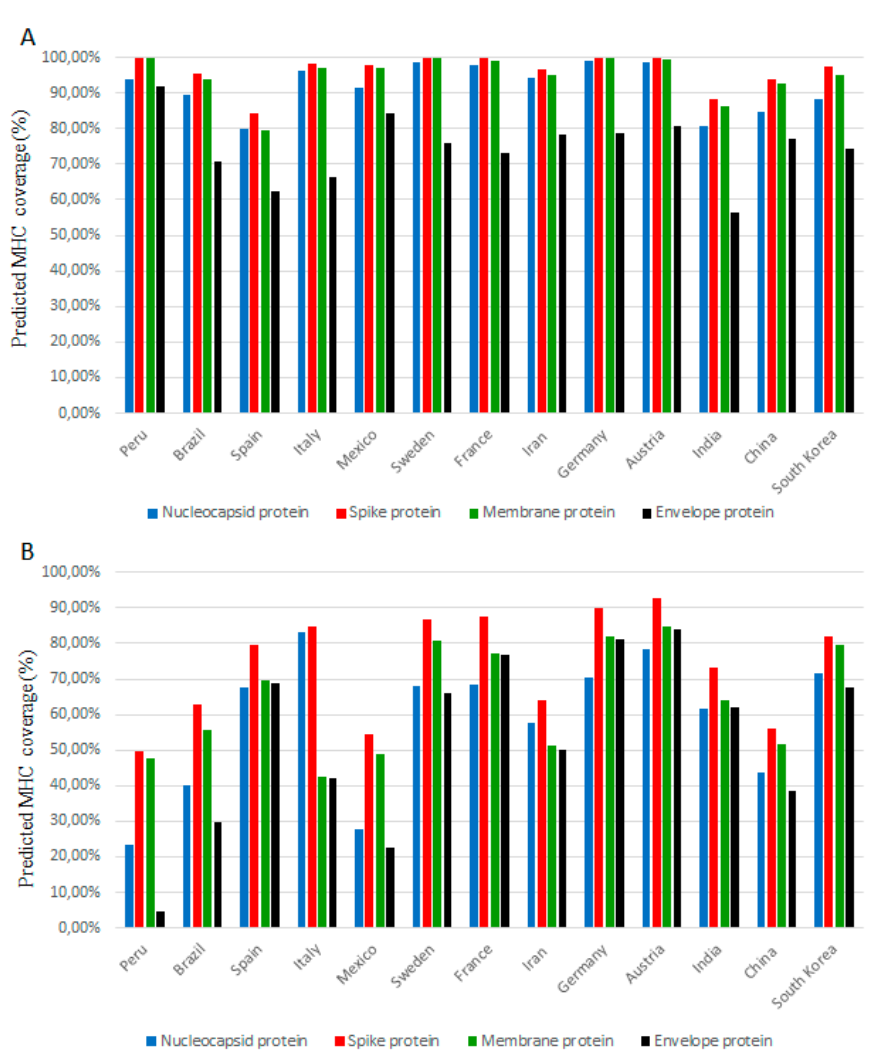
Figure 1. The predicted population coverage of most frequent Major Histocompatibility Complex (MHC) class I ( A ) and MHC class II ( B ) epitopes (predicted in silico) of SARS-CoV-2 structural proteins. The representation of MHC class I and II allele distribution in selected countries. The y -axis shows the percentage of population coverage according to the IEDB tool. The complete data are listed in Supplementary Table S5. Specific controls include results and tool validation on other viruses (Table S6) as well as results for scrambled sequences (Table S7).